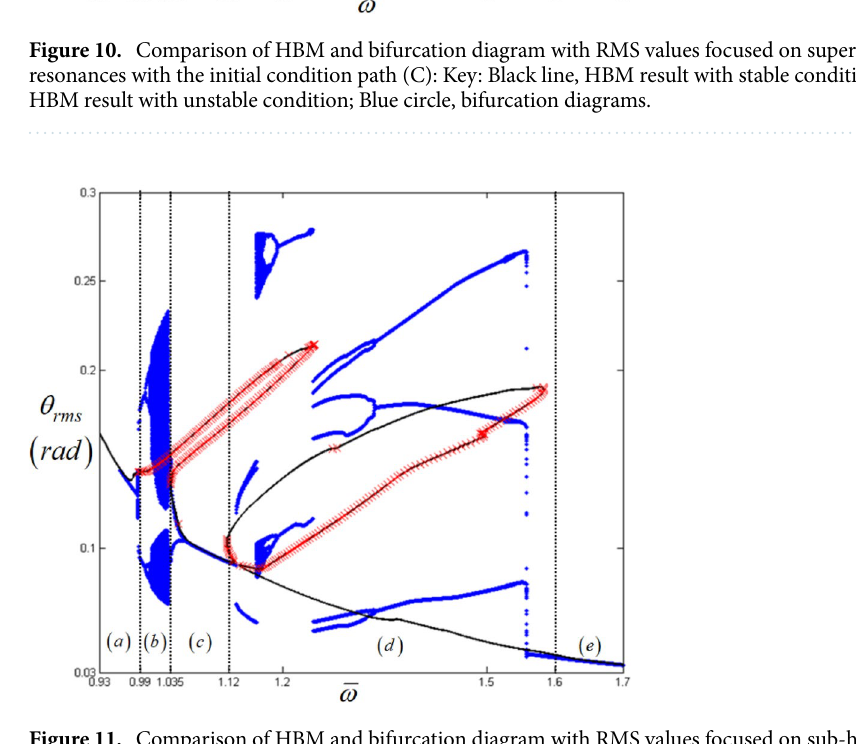
Figure 11. Comparison of HBM and bifurcation diagram with RMS values focused on sub-harmonic resonances with the initial condition path (A): Key: Black line, HBM result with stable condition; Red times , HBM result with unstable condition; Blue circle, bifurcation